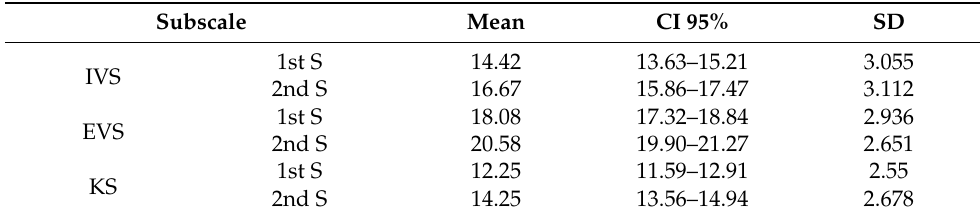
Table 2. Results of the descriptive analysis in each subscale.